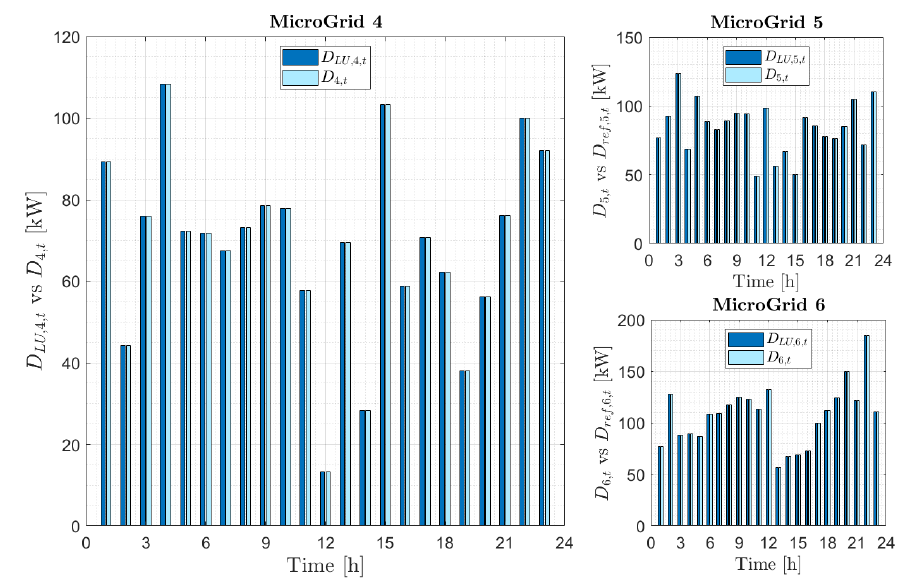
Figure 12. Power exchange between the nodes and the LUs (microgrids) compared with their reference values.